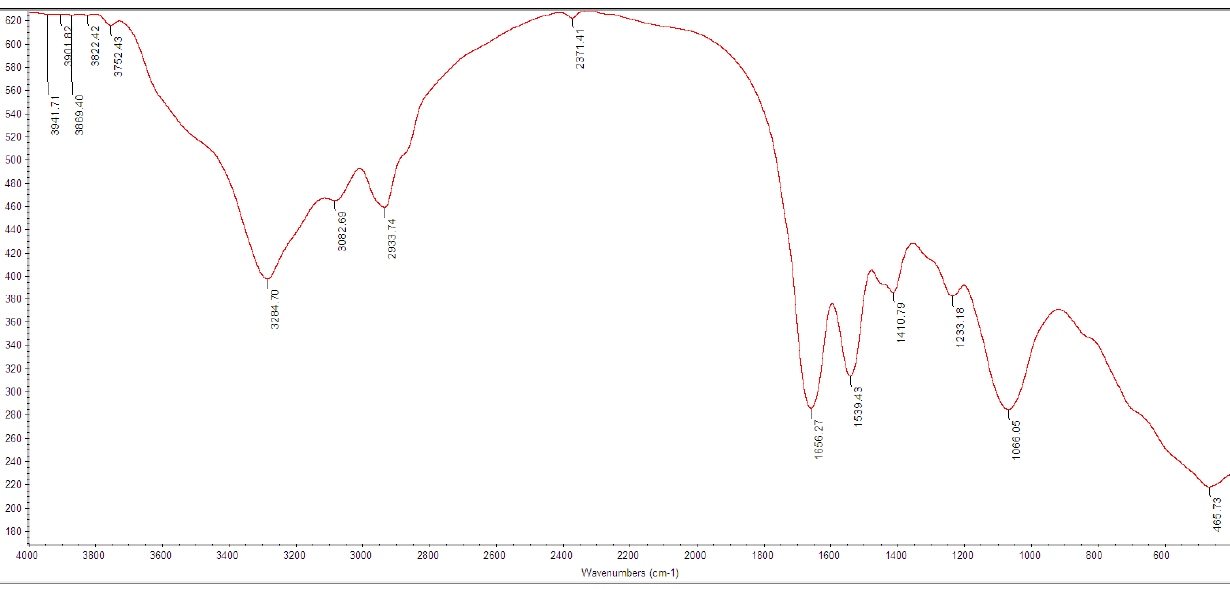
Figure 8. FTIR spectrum of the biogenic TeNPs produced by Gayadomonas sp. TNPM15.